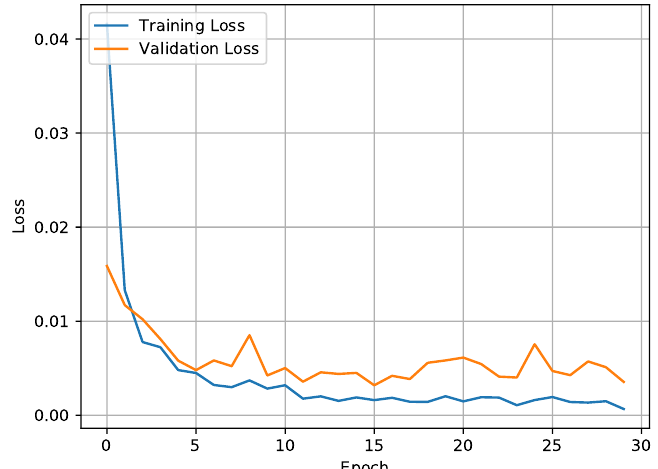
Figure 7. Training loss vs. validation loss.